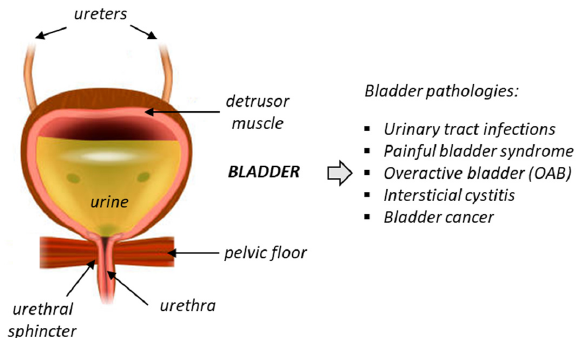
Figure 1. Anatomy of the bladder and the main associated pathologies.